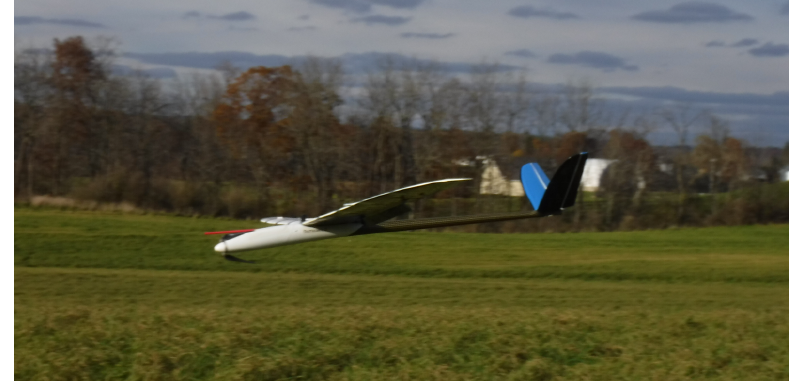
Figure 9. The Vulture, a small fixed-wing UAS based on a 2.5 m span model sailplane. It is equipped with an autopilot, onboard computer, and dual power systems permitting 30 min of flight time and more than 10 h of avionics run time. This allows multiple consecutive flights without disrupting the modeling